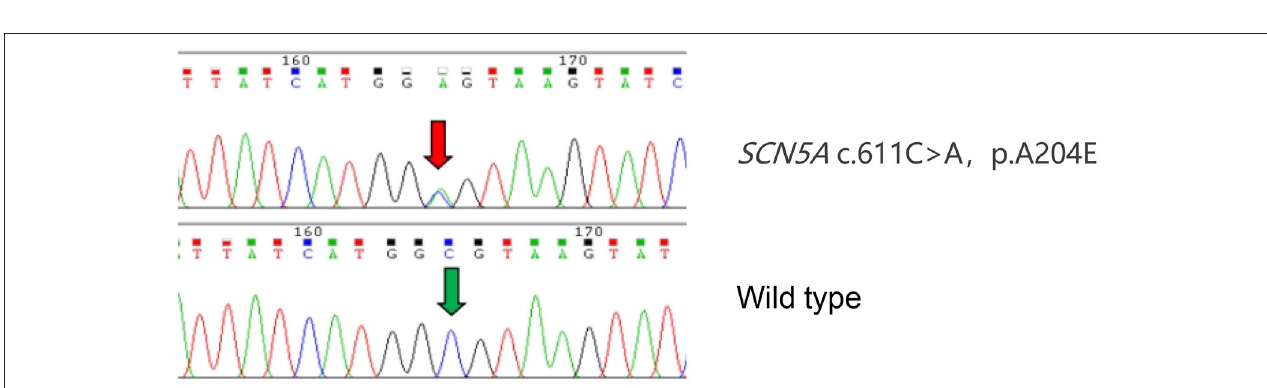
FIGURE 3 | Identification of the SCN5A variant. Sanger sequence SCN5A in a wild-type (WT) subject and proband confirms the presence of the A204E variation. The variant nucleotide residue is indicated by a red arrow. The same nucleotide residue of WT is indicated by a green